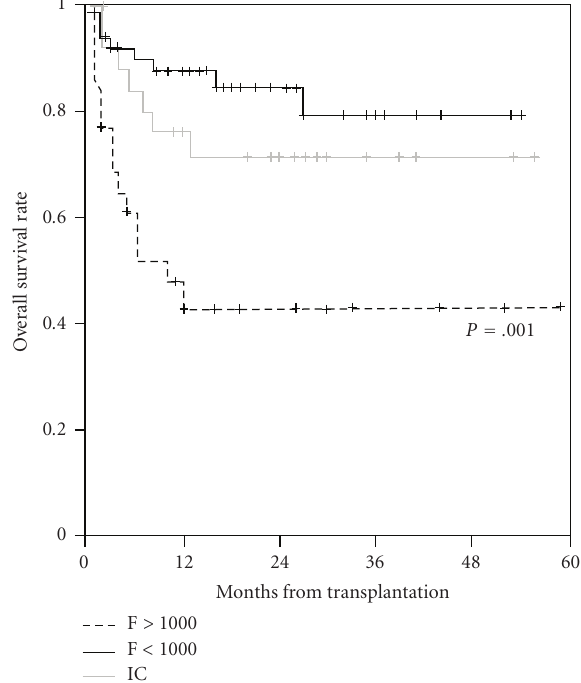
Figure 5: E ff ect of management of iron levels with iron chelation therapy on outcome in pediatric HSCT patients [30]. Patients receiving iron chelation (IC) therapy to reduce high iron load demonstrated survival levels similar to patients with low serum ferritin (F) levels at transplantation ( N =